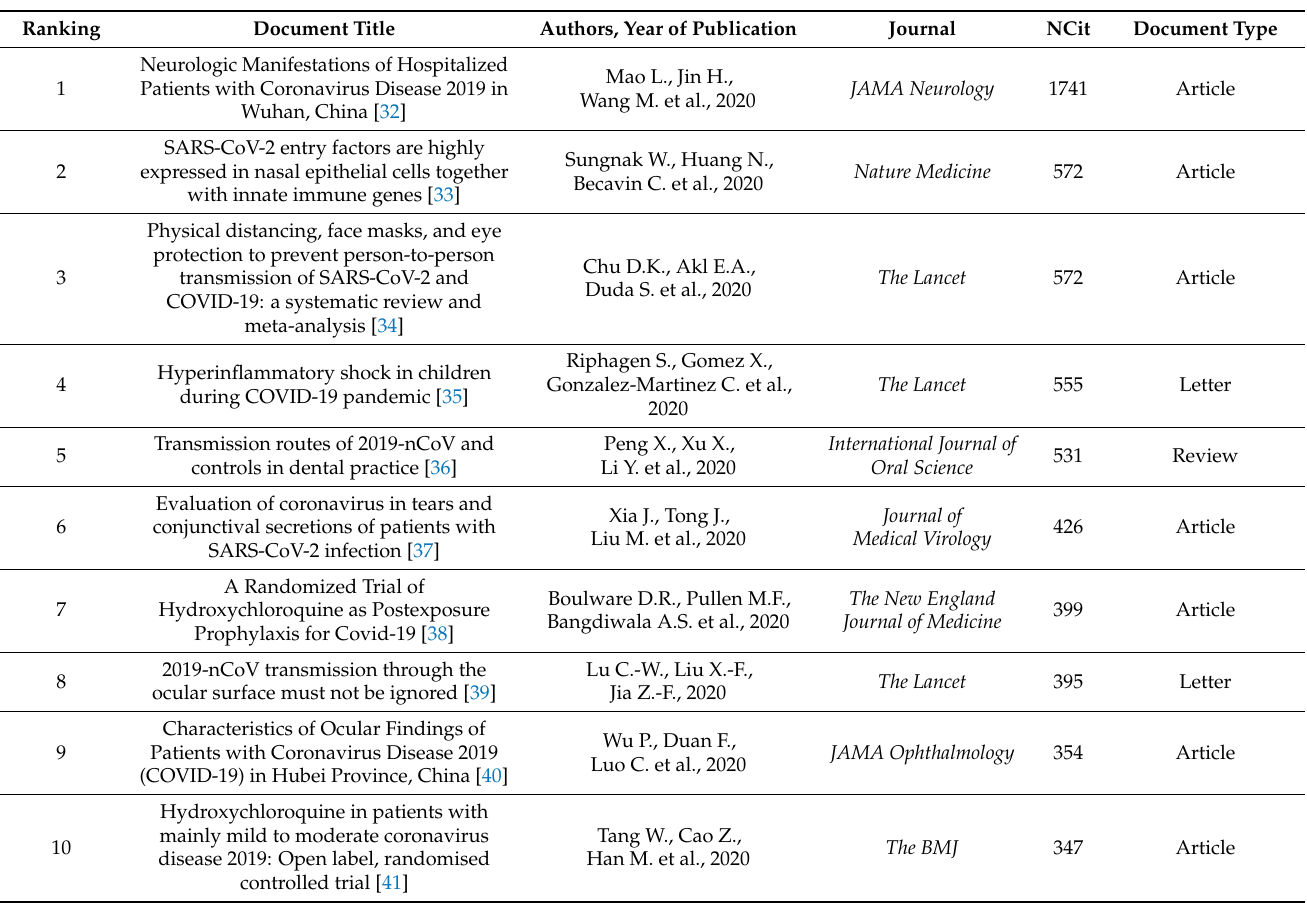
Table 4. Top 10 cited articles in the eye-related COVID-19 literature (2019–2021). Data retrieved in